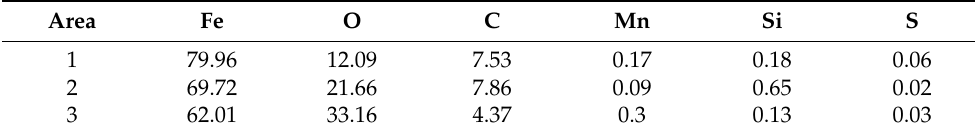
Figure 4. SEM micrographs of surface damage of the U-shaped rings, ( a ) wear load 4000 N; ( b ) wear load 6000 N; ( c ) wear load 8000 N. 1: area 1; 2: area 2; 3: area3. Table 4. EDS composition analysis of the worn surface under different wear loads (wt.%).